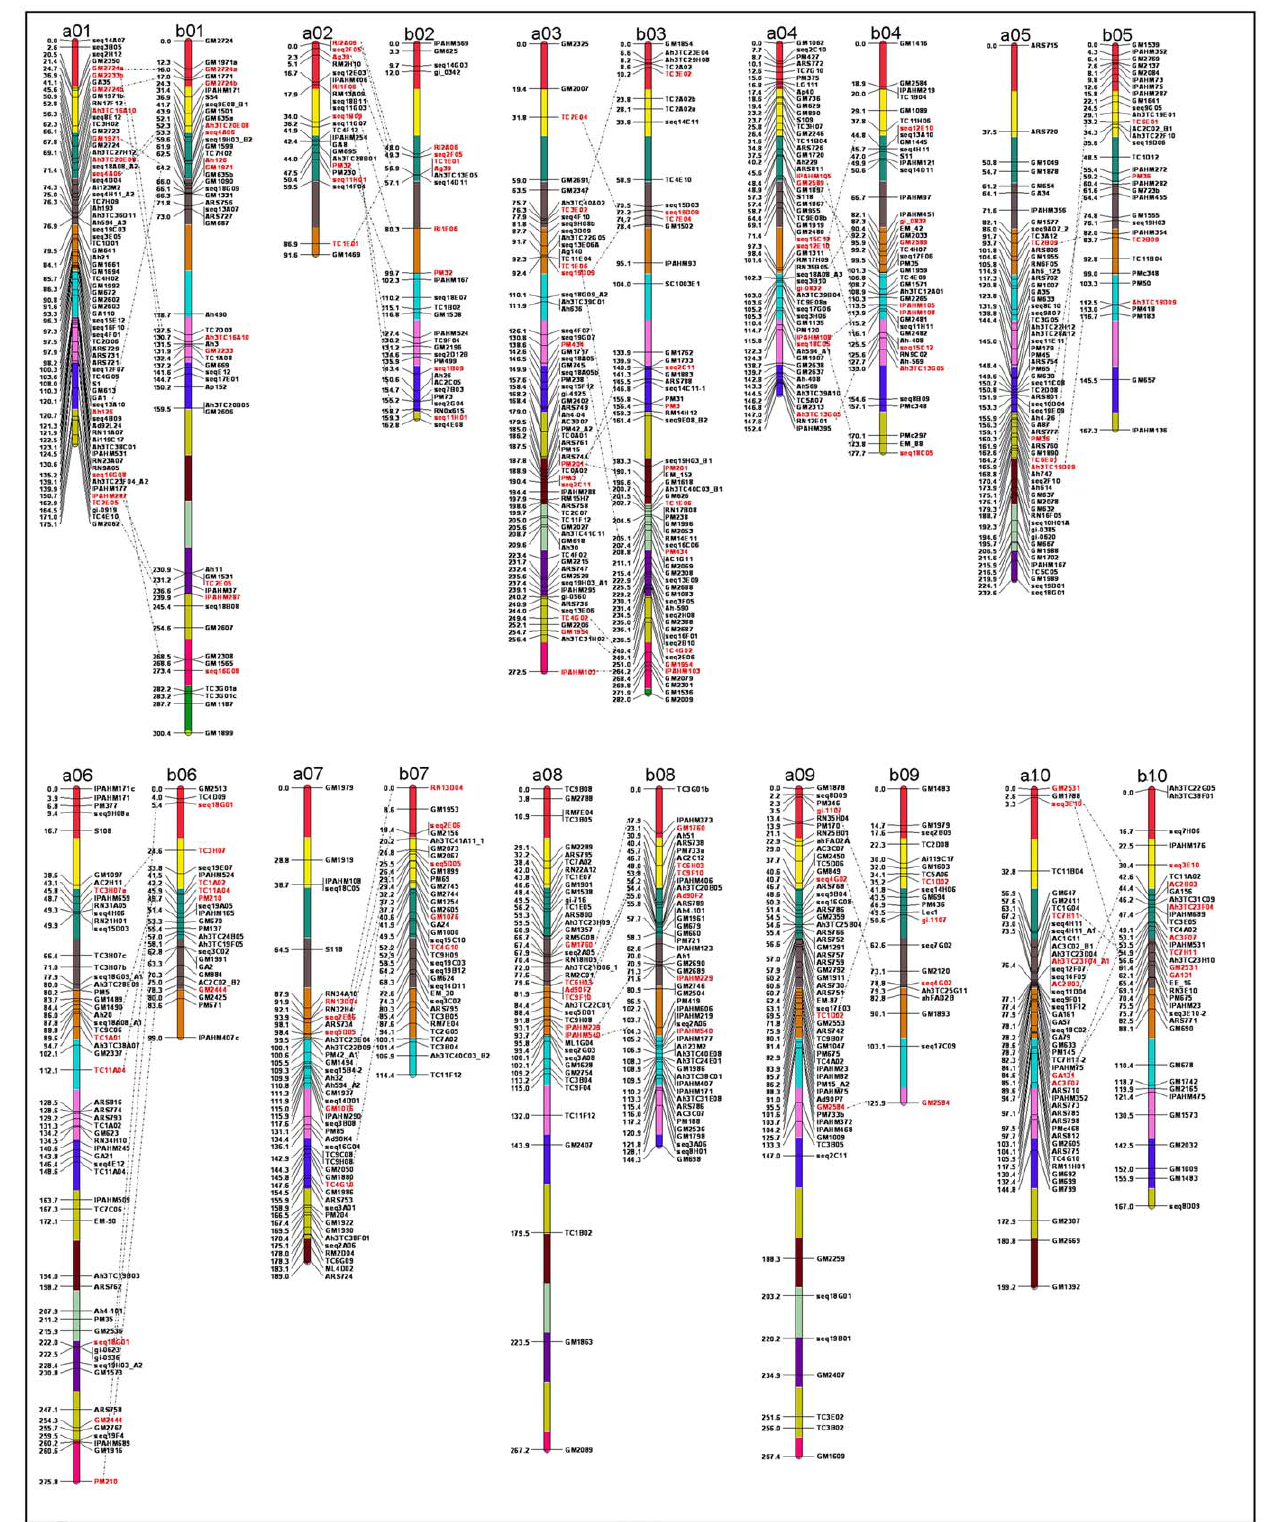
Figure 1. A microsatellite consensus genetic map comprising 897 marker loci based on 11 mapping populations. Markers are shown on right side of the LG while map distances are shown on the left side. Each LG has been divided into 203 BINs of 20 cM each. The homoeologous loci between the corresponding LGs in the reference consensus map are indicated in red colour.